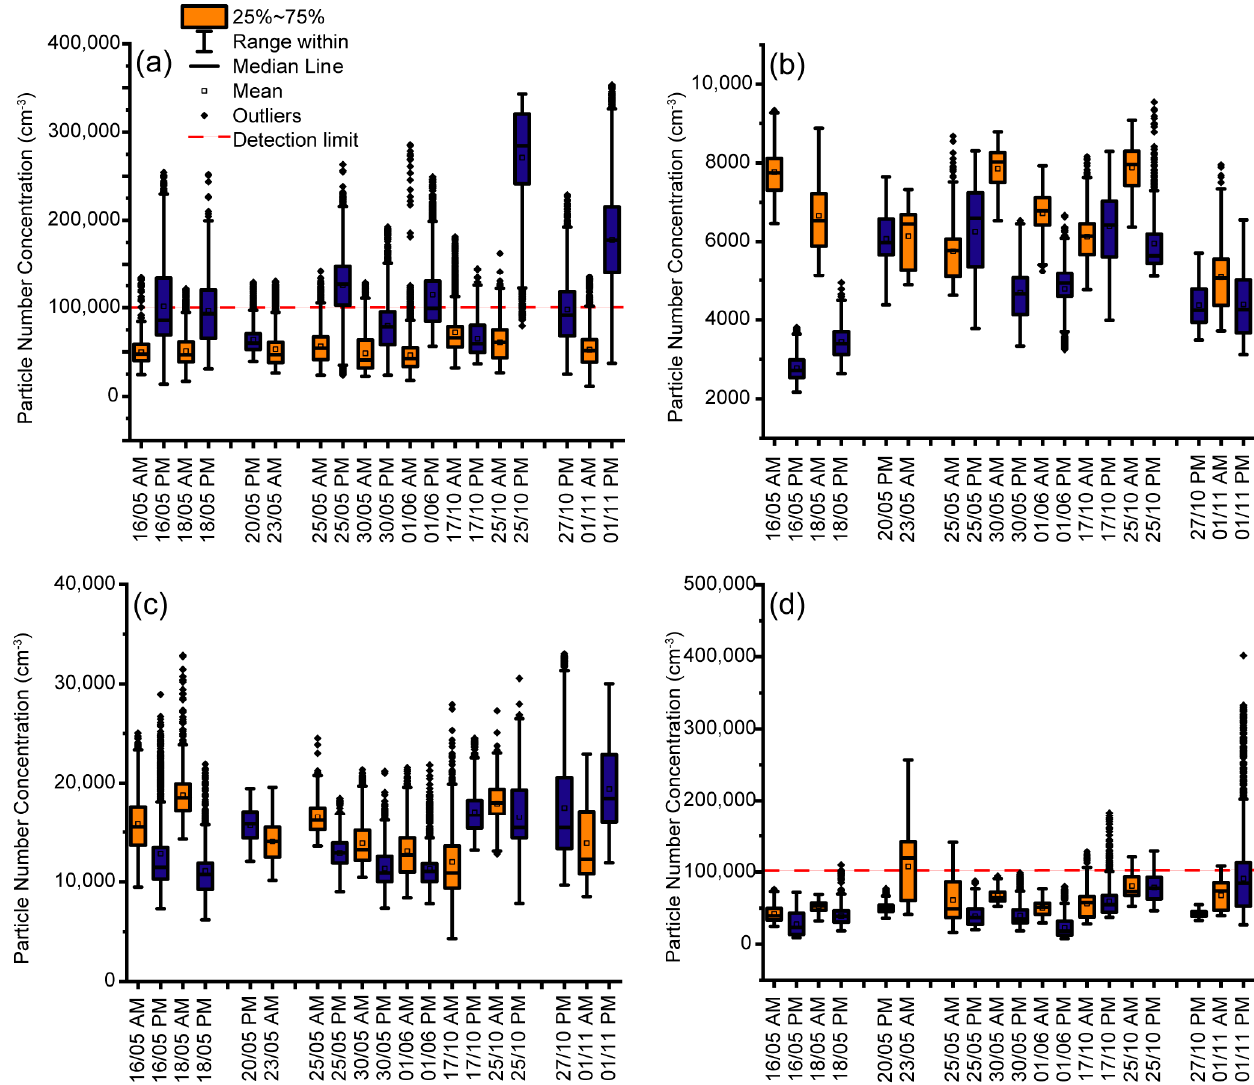
Figure 3. Box plots showing particle counts measured on public transport in the morning (orange) and evening (blue) on the selected dates of May–June, October–November, 2018. Values above the dotted line are above the limit of detection of the instrument and may be subject to undercounting. Most of the measurements are part of a pair performed on the same day, gaps represent a morning or afternoon when measurements could not be performed. Particle counts are shown on ( a ) the state railway train, ( b ) the MRT underground, ( c ) the BTS Skytrain and ( d ) the public bus.